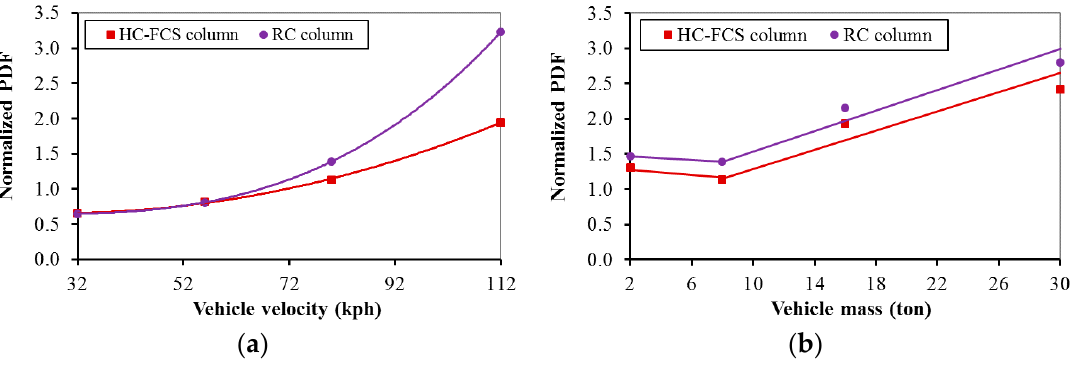
Figure 8. Effects of: ( a ) vehicle velocity and ( b ) vehicle mass on the PDF of the HC-FCS and RC columns.